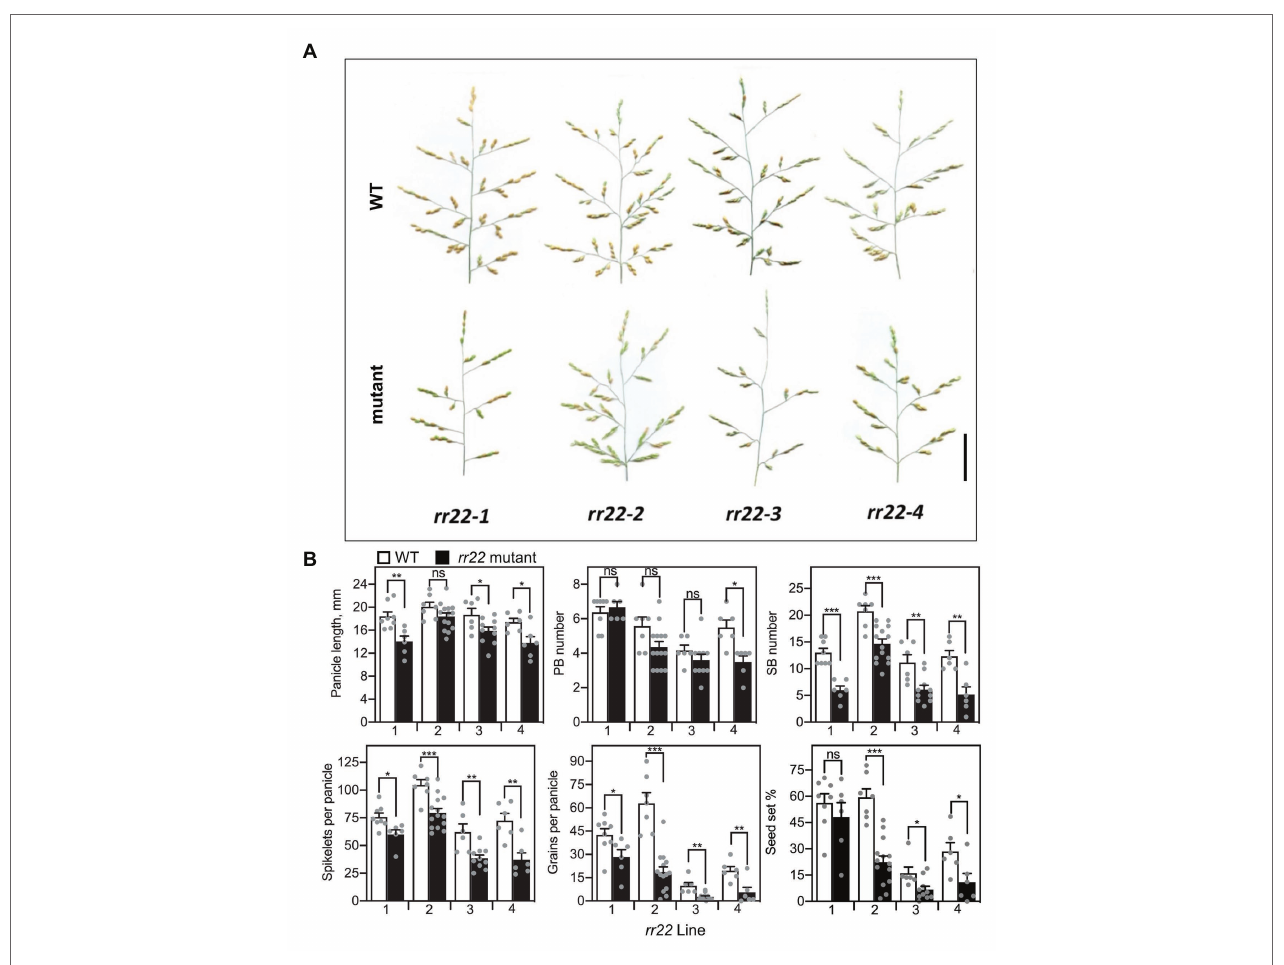
FIGURE 6 | Panicle phenotypes of Tos17 rr22 lines. (A) Panicles of rr22-1 , rr22-2 , rr22-3 , and rr22-4 lines and their WT siblings. Scale bar = 5 cm. (B) Yield parameters of the rr22 lines, including panicle length, PB and SB number, spikelets and grains per panicle, and percent seed set ( n ≥ 6). The T -test was used for statistical comparison of each rr22 line to its WT sibling (* p < 0.05; ** p < 0.01; *** p < 0.001; ns, not